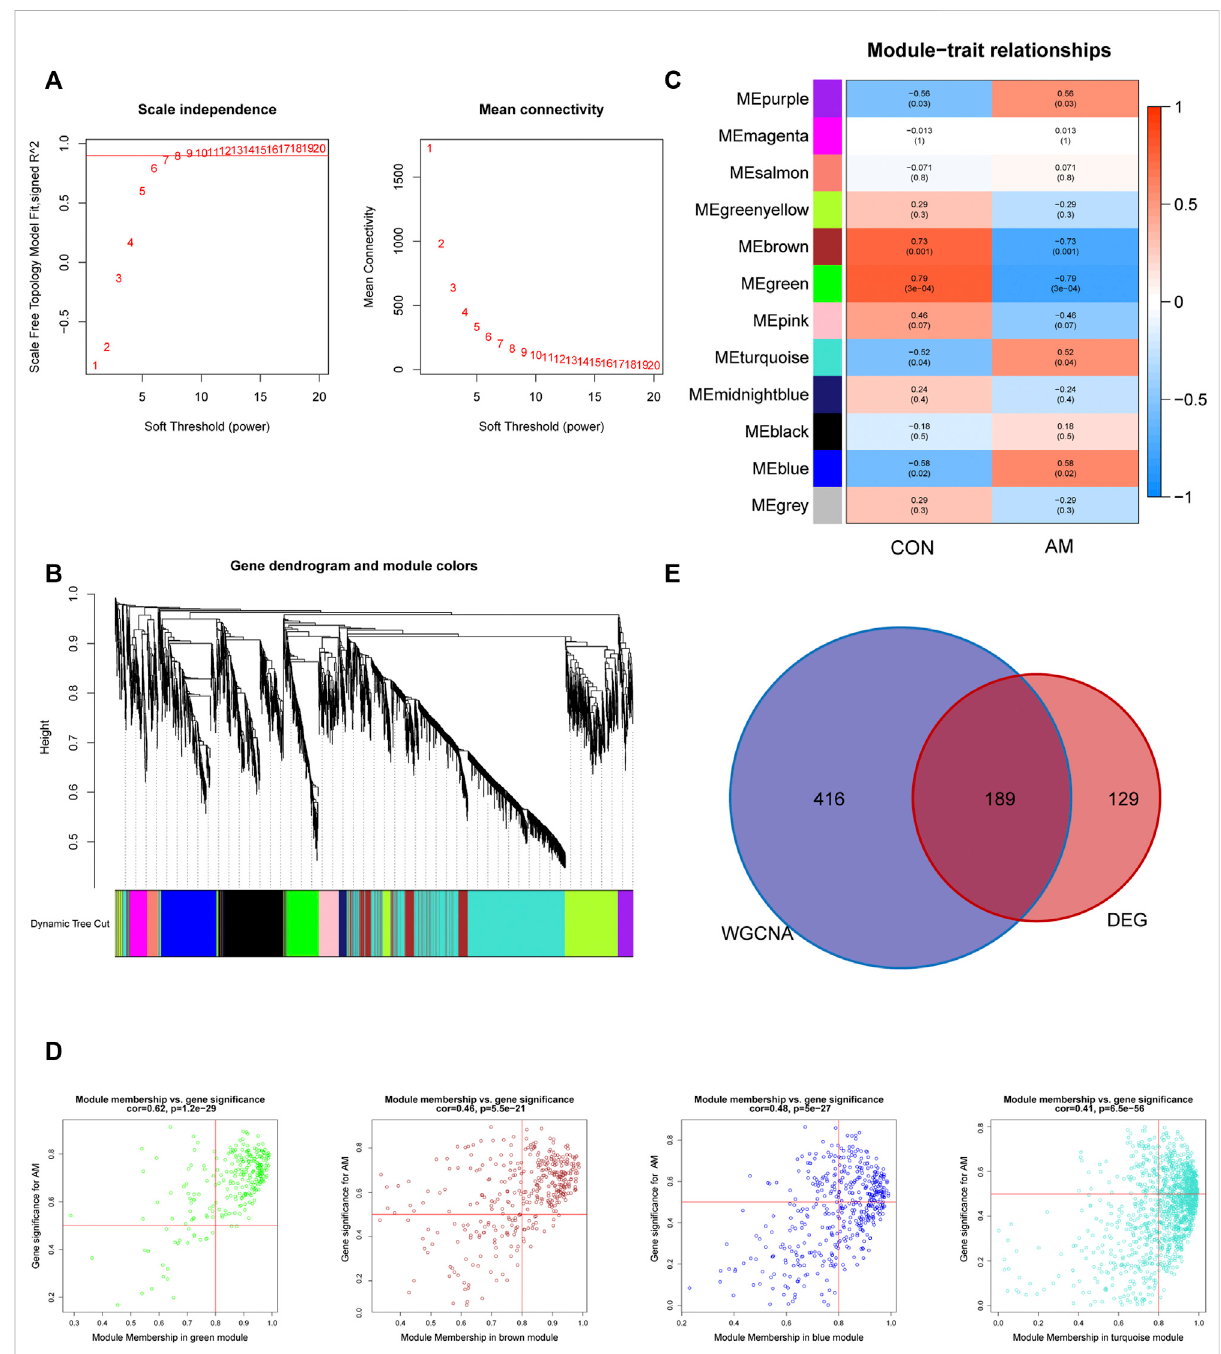
FIGURE 3 Construction of gene co-expression networks associated with adenomyosis through WGCNA. (A) Determination of the soft-thresholding power ( β ). The analysis of the scale-free fi t index for different soft-thresholding powers is shown in the left panel, and the mean connectivity for different soft-thresholding powers is shown in the right panel. (B) The cluster dendrogram of genes based on the dissimilarity of TOM. (C) The heatmap of correlation between genes in different modules and the clinical traits. (D) The correlation between GS for AM and MM in four modules (blue, purple, green and brown). One plot represents one gene. The criteria were set as |MM| > 0.8 and |GS| > 0.5. (E) Venn diagram of the hub genes obtained by intersecting DEGs and the adenomyosis-related key module genes identi fi ed by WGCNA. DEGs: differentially expressed genes; GS: gene signi fi cance; MM: module membership; TOM: topological overlap measure; WGCNA: weighted gene co-expression network